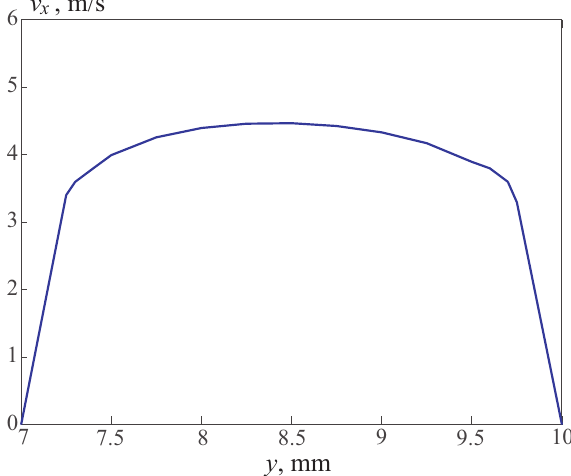
Figure 11. Radial distribution of the axial water velocity in the outlet